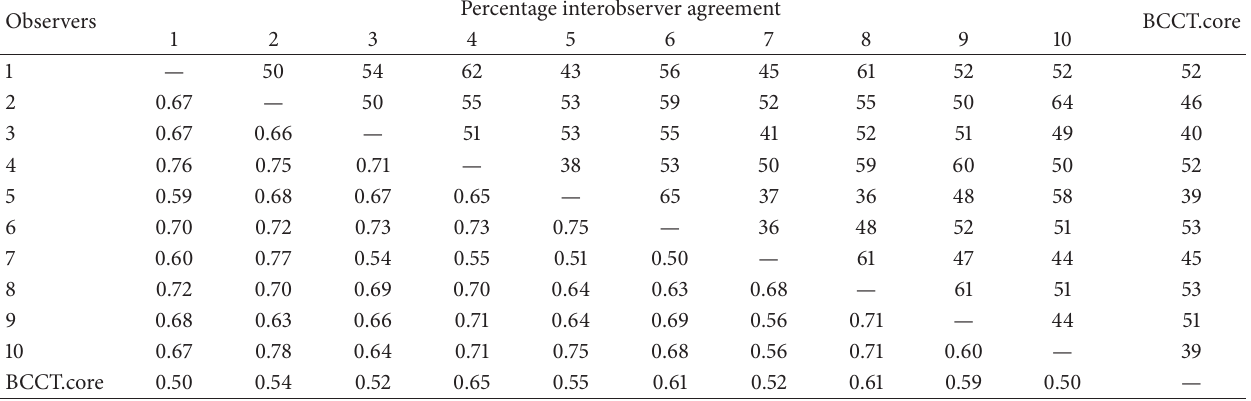
Interobserver weighted